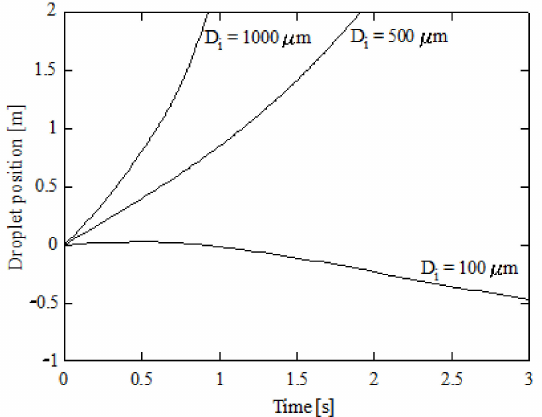
Figure 8. Droplet position against time for several initial diameters; 5% initial ammonia concentration, 100 ◦ C initial gas temperature, and 5 ◦ C initial liquid temperature.